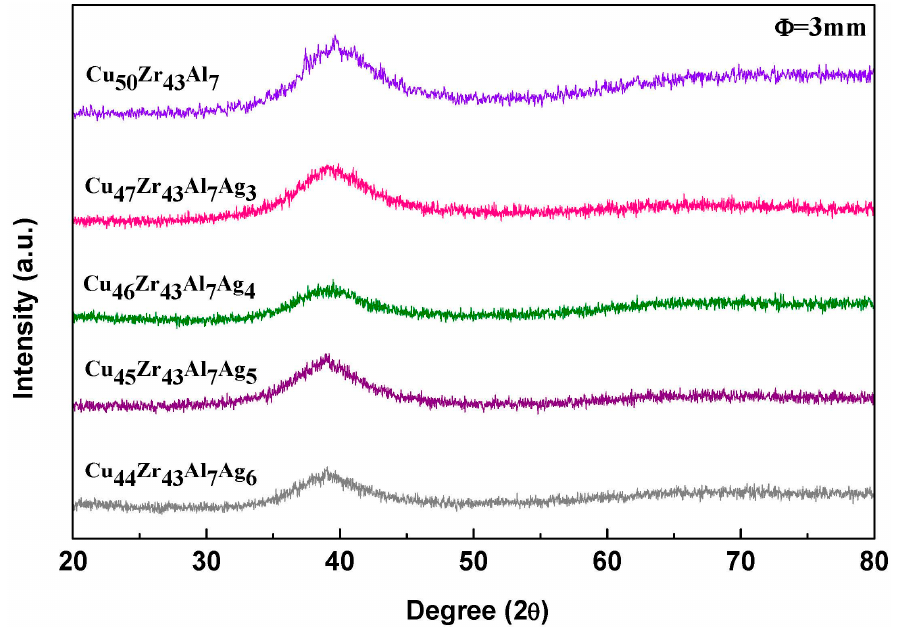
Figure 1. XRD patterns of the as-cast Cu 50 − x Zr 43 Al 7 Ag x ( x = 0, 3, 4, 5, 6)